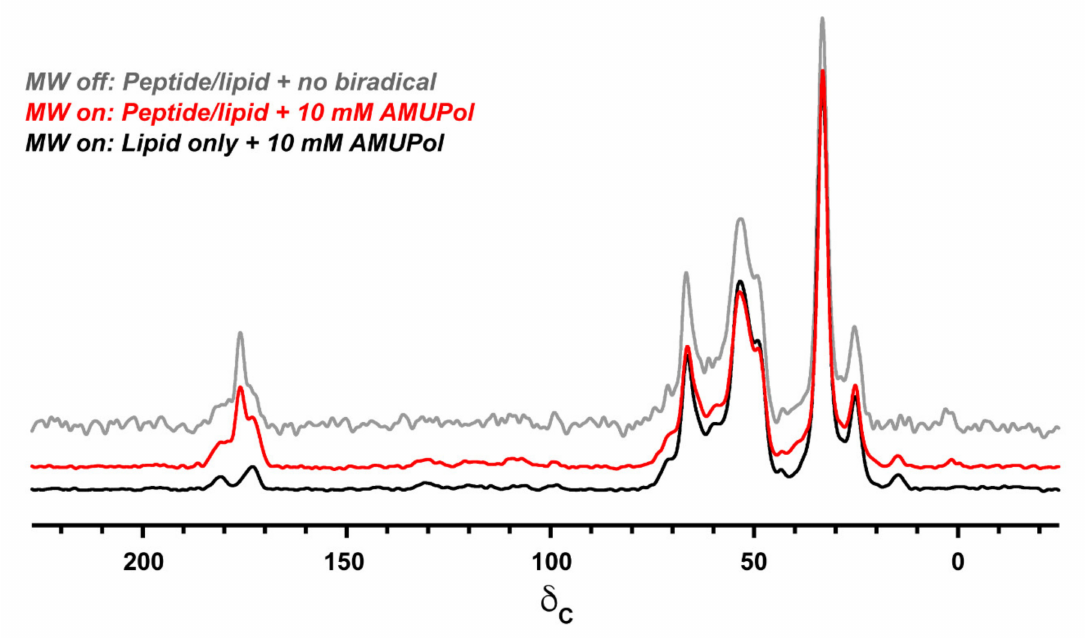
Figure 7. Comparison of 13 C chemical shift spectra for a DNP-enhanced sample containing 5.5 / 2.7 / 2 / 1 DPPC-d 62 / DPPC / POPG / cholesterol and 2 mol% K 4 made with bu ff er containing 10% DMSO and 10